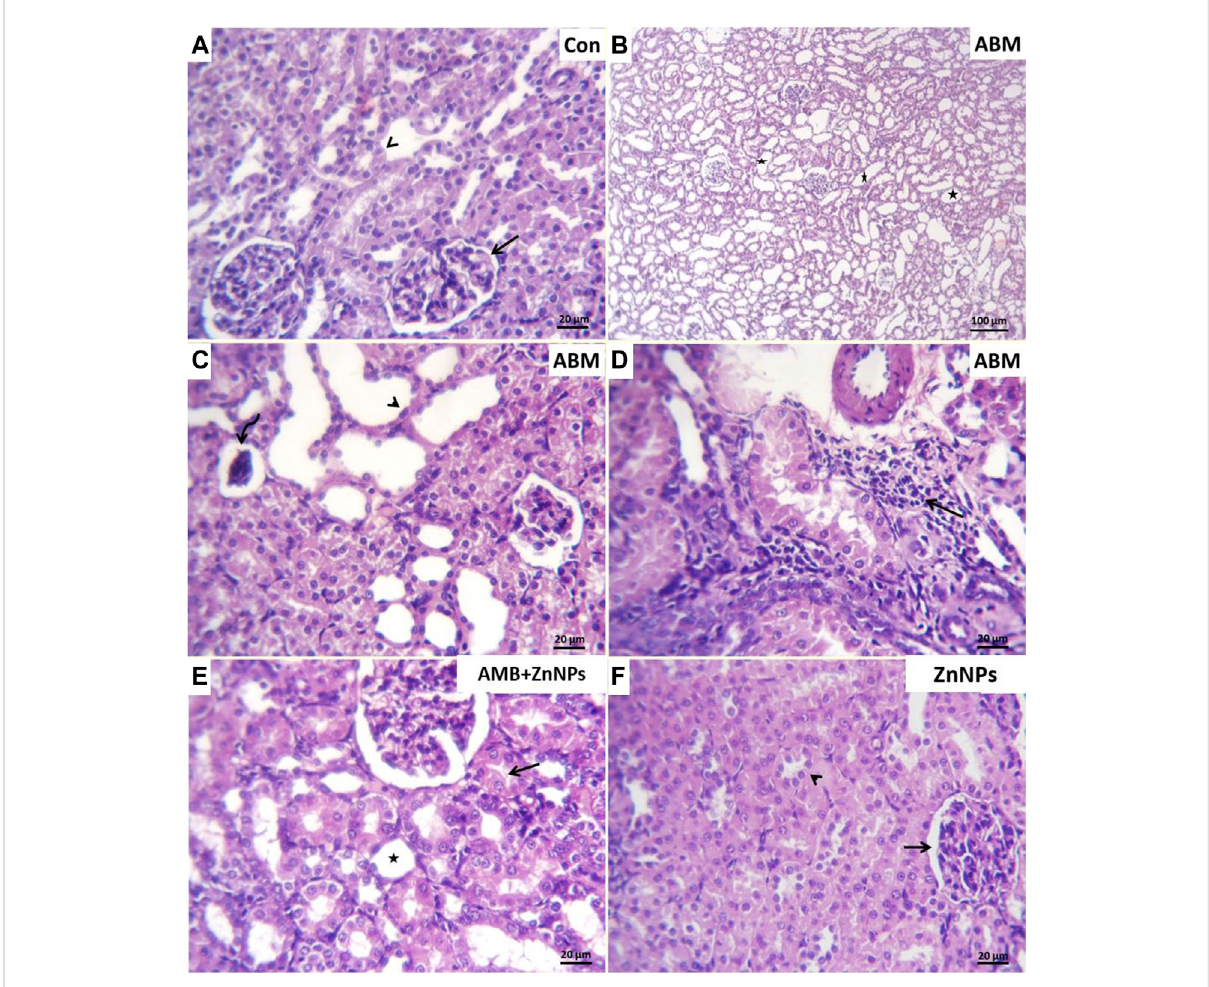
FIGURE 5 Photomicrograph of H&E stained sections from kidney showing some parameters (Dilated tubular lumina, glomerular shrinkage, degenerative changes, necrotic changes, round cells in fi ltrations). (A) : Normal glomerular architectures (arrow) and surrounding renal tubule (arrowhead) in control (G I). (B) : Marked dilated lumina (stars), (C) . fl attened epithelial lining (arrow head) in most renal tubules, glomerular tufts shrinkage (curved arrow), (D) : perivascular round cells in fi ltration (arrow) in rats group treated with abamectin (ABM; G II). (E) : Few tubular dilatation (star)